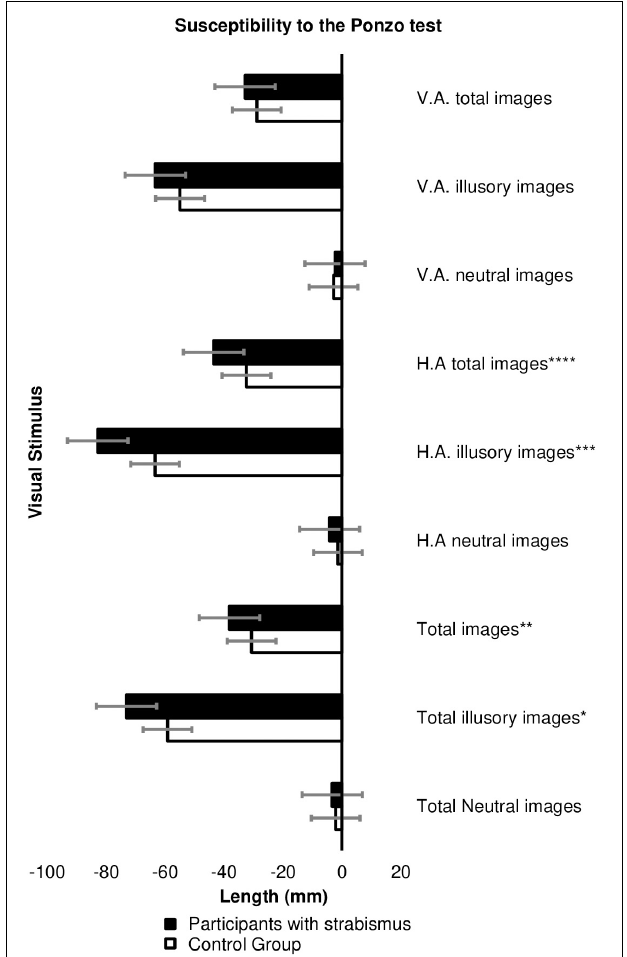
FIGURE 2 | Estimate of the image size (in millimeters) between the Cases ( n = 45) versus Controls Groups ( n = 62) in the Ponzo test. HA, horizontal adjustment images; VA, vertical adjustment images. * p -value = 0.030; ** p -value = 0.0037, *** p -value = 0.006; **** p -value = 0.005. The error bars shown represent the Standard